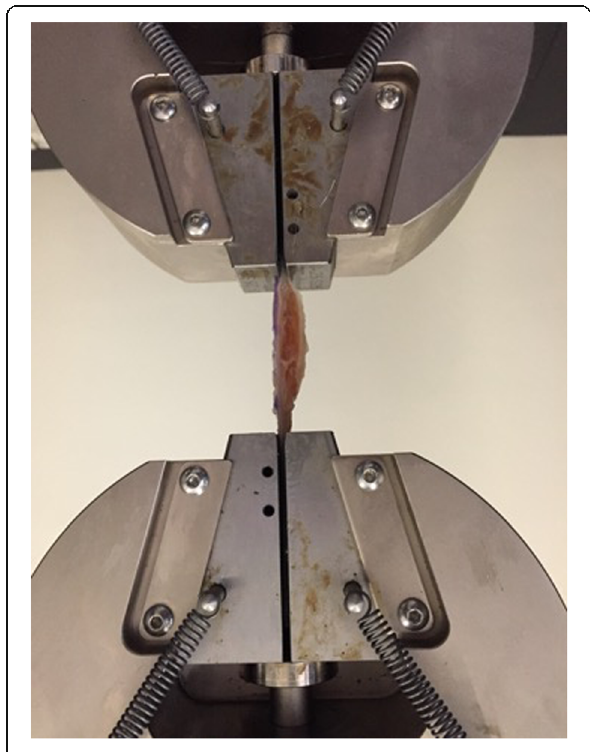
Fig. 3 Load to failure testing of a Patellar tendon specimen